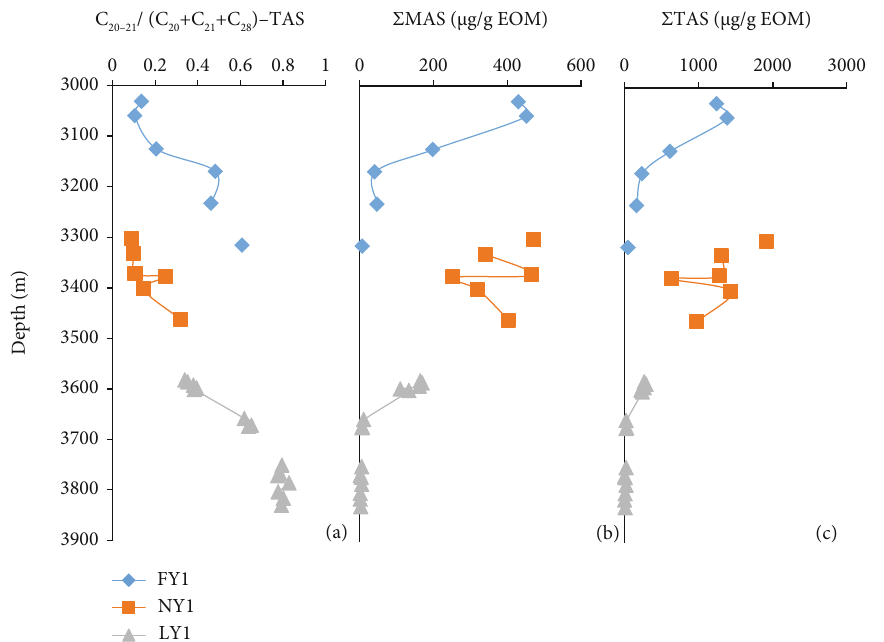
/ ð C + C + C Þ − TAS . (b) 20 − 21 20 21 28 -C triaromatic 26 28